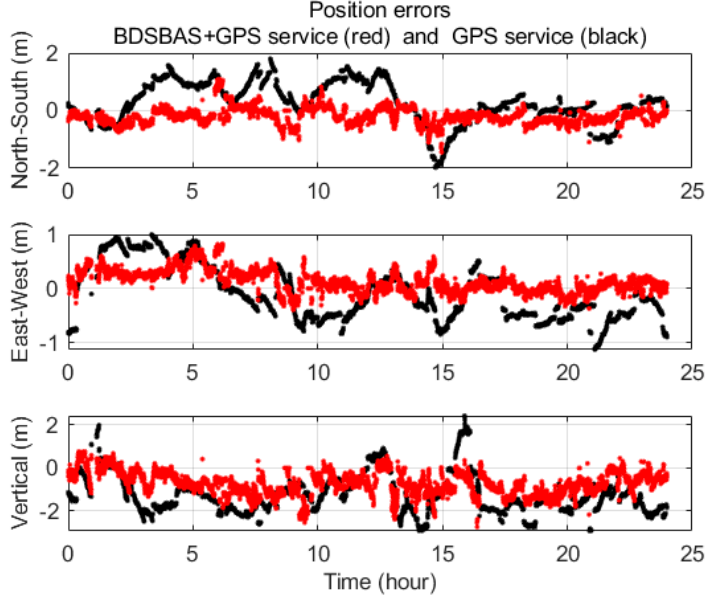
Figure 4. Comparison of position errors between the BDSBAS + GPS SF service (red lines) and the GPS SF service (black lines).